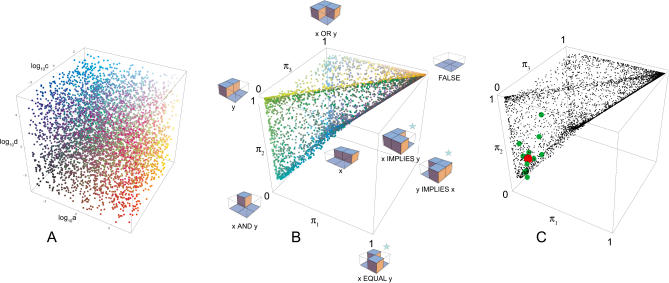
Parameter Space and Phenotype Space of the
lac CRIFs
(A) Parameter space is the space of the three parameters
a, c, and
d that describe the relative binding affinity of RNAp, LacI, and CRP to their sites in the
lac CRR; 5,000 points log-uniformly distributed in this space are shown. (B) Phenotype space, whose axes correspond to the ratio of plateaus I, II, III to plateau IV in the input function (see
Figure 3C for definition of these plateaus). The phenotypes of the points in (A) are shown; corresponding points in parameter and phenotype space have the same color. Also plotted are the input functions that correspond to the eight extreme corners of phenotype space. Input functions marked with a star cannot be reached with point mutations in the regulator binding sites according to the model. In the case of the (1, 1, 1) vertex, all plateaus are equal (either to 1 or 0). We depict this situation by the FALSE gate. (C) Phenotype space: the experimentally observed input functions are indicated in green dots and that of the wild type promoter region in a red dot; black dots are the phenotypes of points shown in (A).